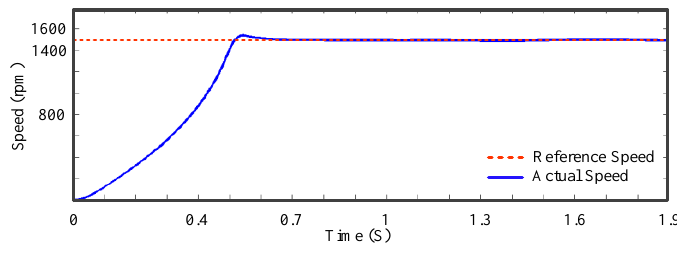
Figure 13. The speed curve of induction motor (IM).